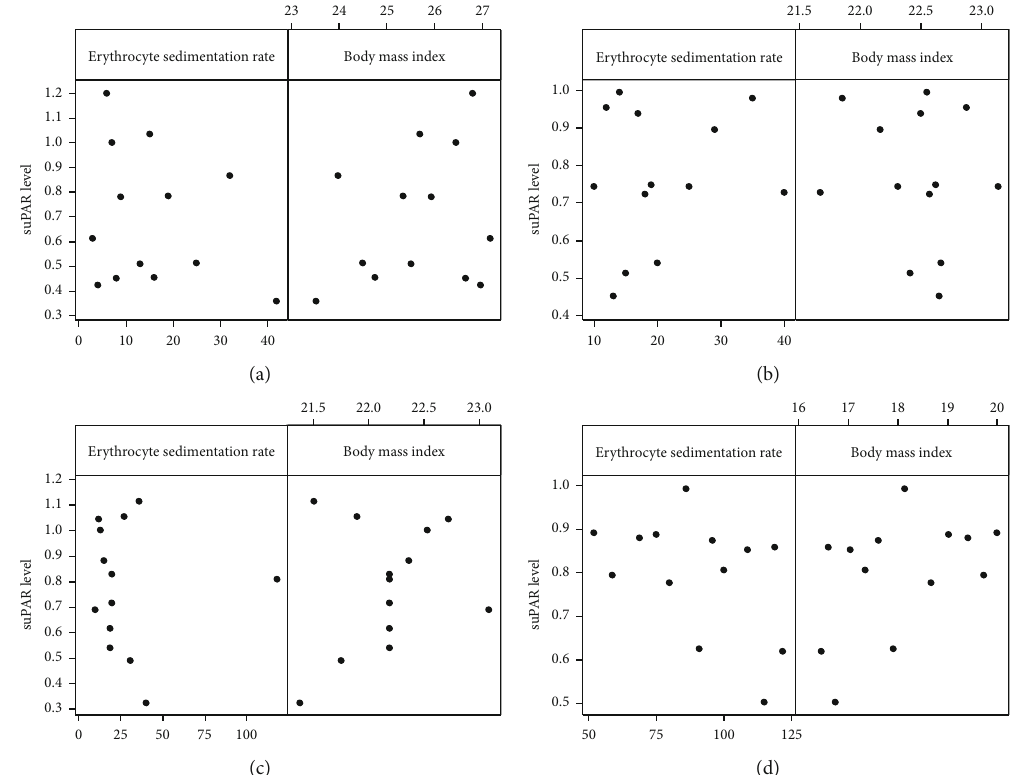
Figure 2: Scatterplot between suPAR levels with each predictor for the subject: (a) minimal lesion ; (b) mod advance ; (c) far advance ; (d) KP Miller